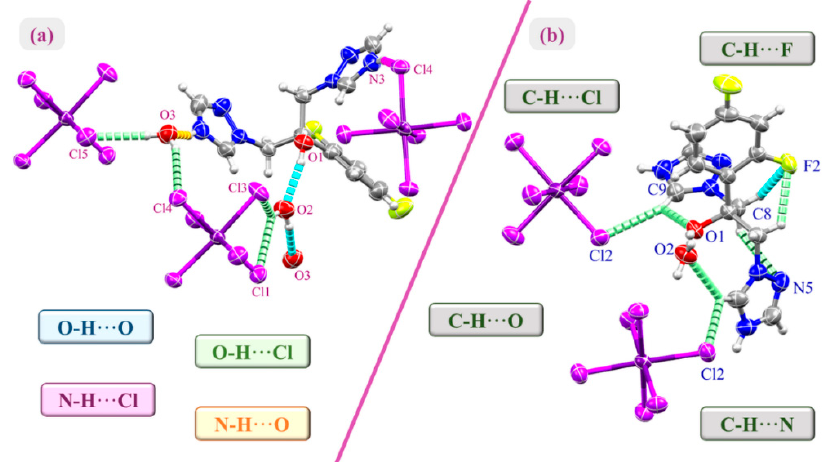
Figure 2. Hydrogen bond interactions in (H2Fluconazole).SnCl 6 .2H 2 O.